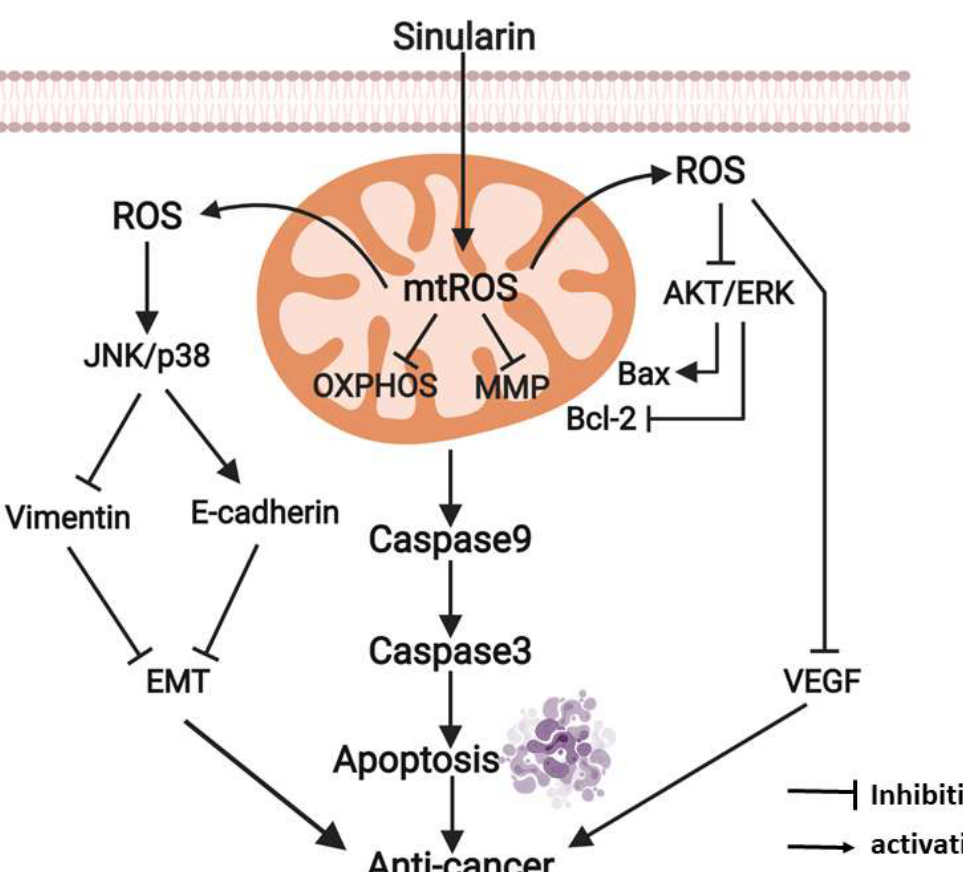
Figure 7. Proposed anti-cancer mechanisms for sinularin in SK-HEP-1 cells. The diagram was created with BioRender.com.